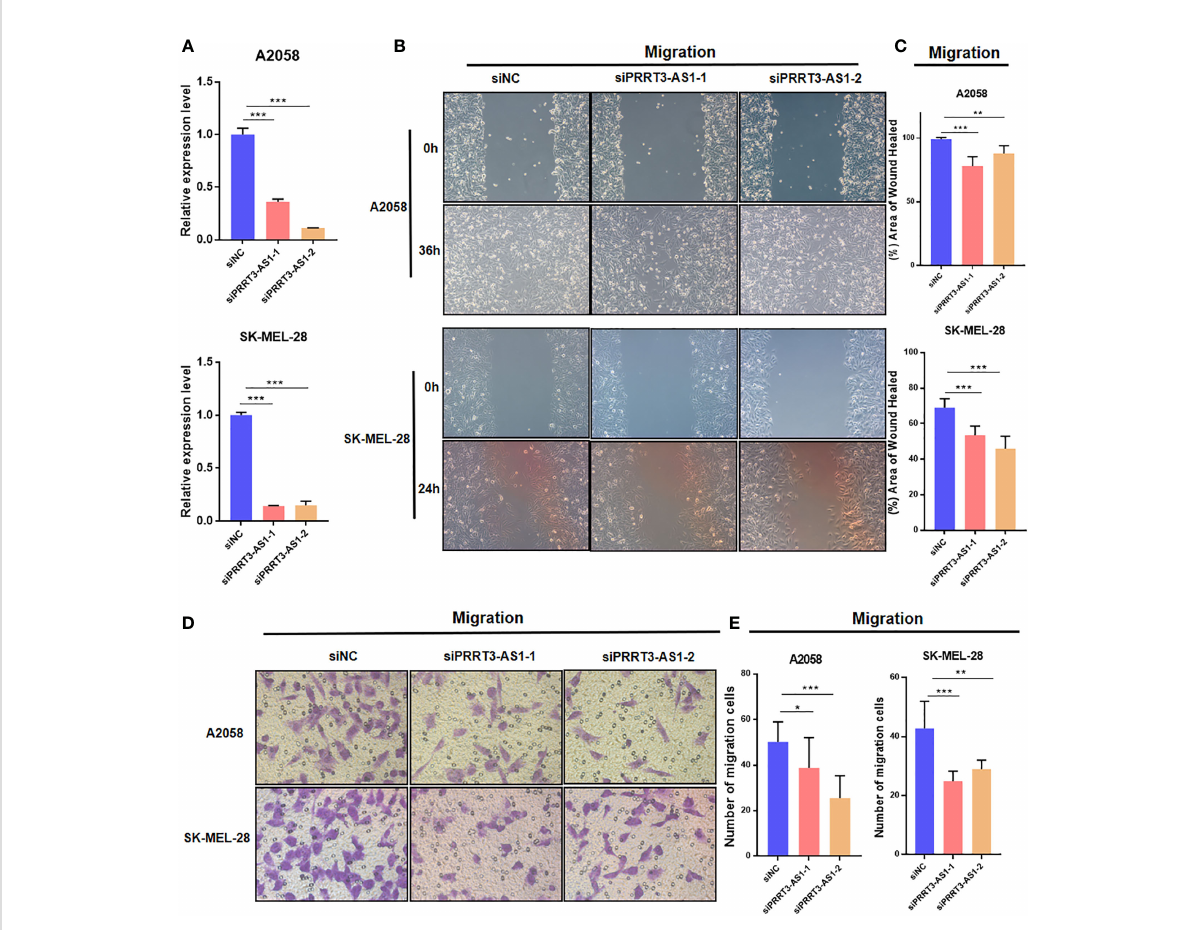
FIGURE 4 Cell model validation of PRRT3-AS1 in A2058 and SK-MEL-28 melanoma cells transfected with siPRRT3-AS1 and vector. (A) qPCR results of PRRT3- AS1 on RNA expression. Representative images (B) and quantitative analysis (C) of the results from the wound healing assay. Representative images (D) and quantitative analysis (E) of the results using transwell assay. * P < 0.05, ** P < 0.01, *** P <